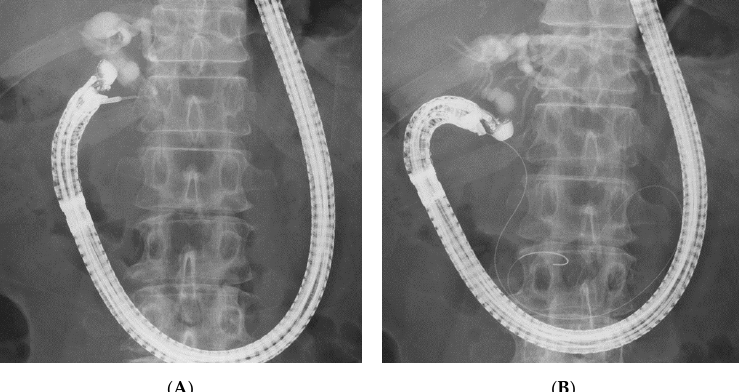
Figure 9. Changing the needle direction after biliary puncture in the PEHBD/D1 route. The proximal extrahepatic bile duct was punctured from the duodenal bulb with an unfavorable needle direction ( A ). Changing the needle direction to the caudal side by pushing the scope to the cranial side and using the up-angle of the scope ( B ). PEHBD/D1, proximal extrahepatic bile duct/duodenal bulb.